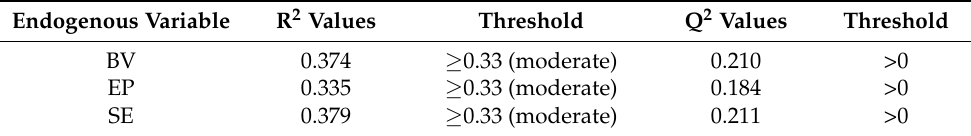
Table 8. R 2 , predictive relevance Q 2